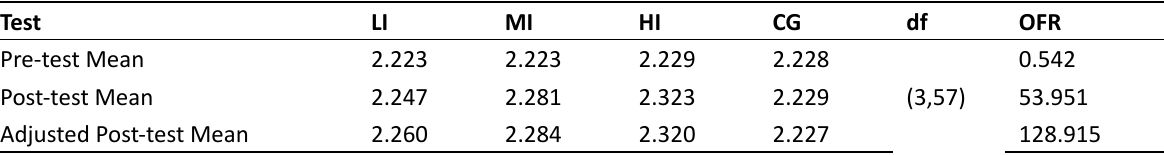
Table 4. showing the analysis of covariance of pre-test, post-test and Adjusted post-test on leg explosive power of experimental and control groups